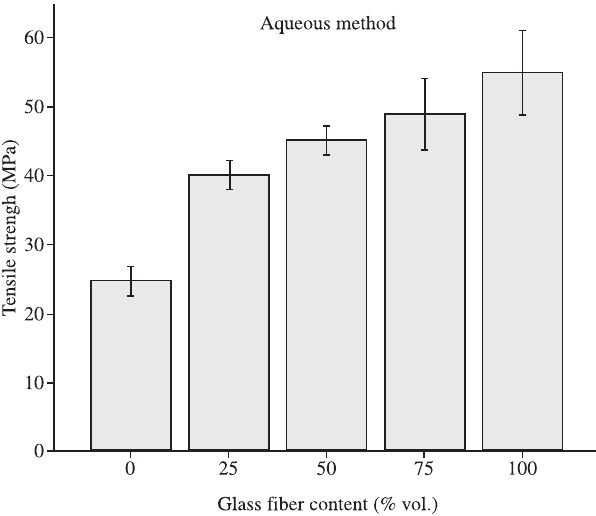
Figure 2. Tensile strength of the composites in relation to the glass fiber content of the mats – Aqueous method.